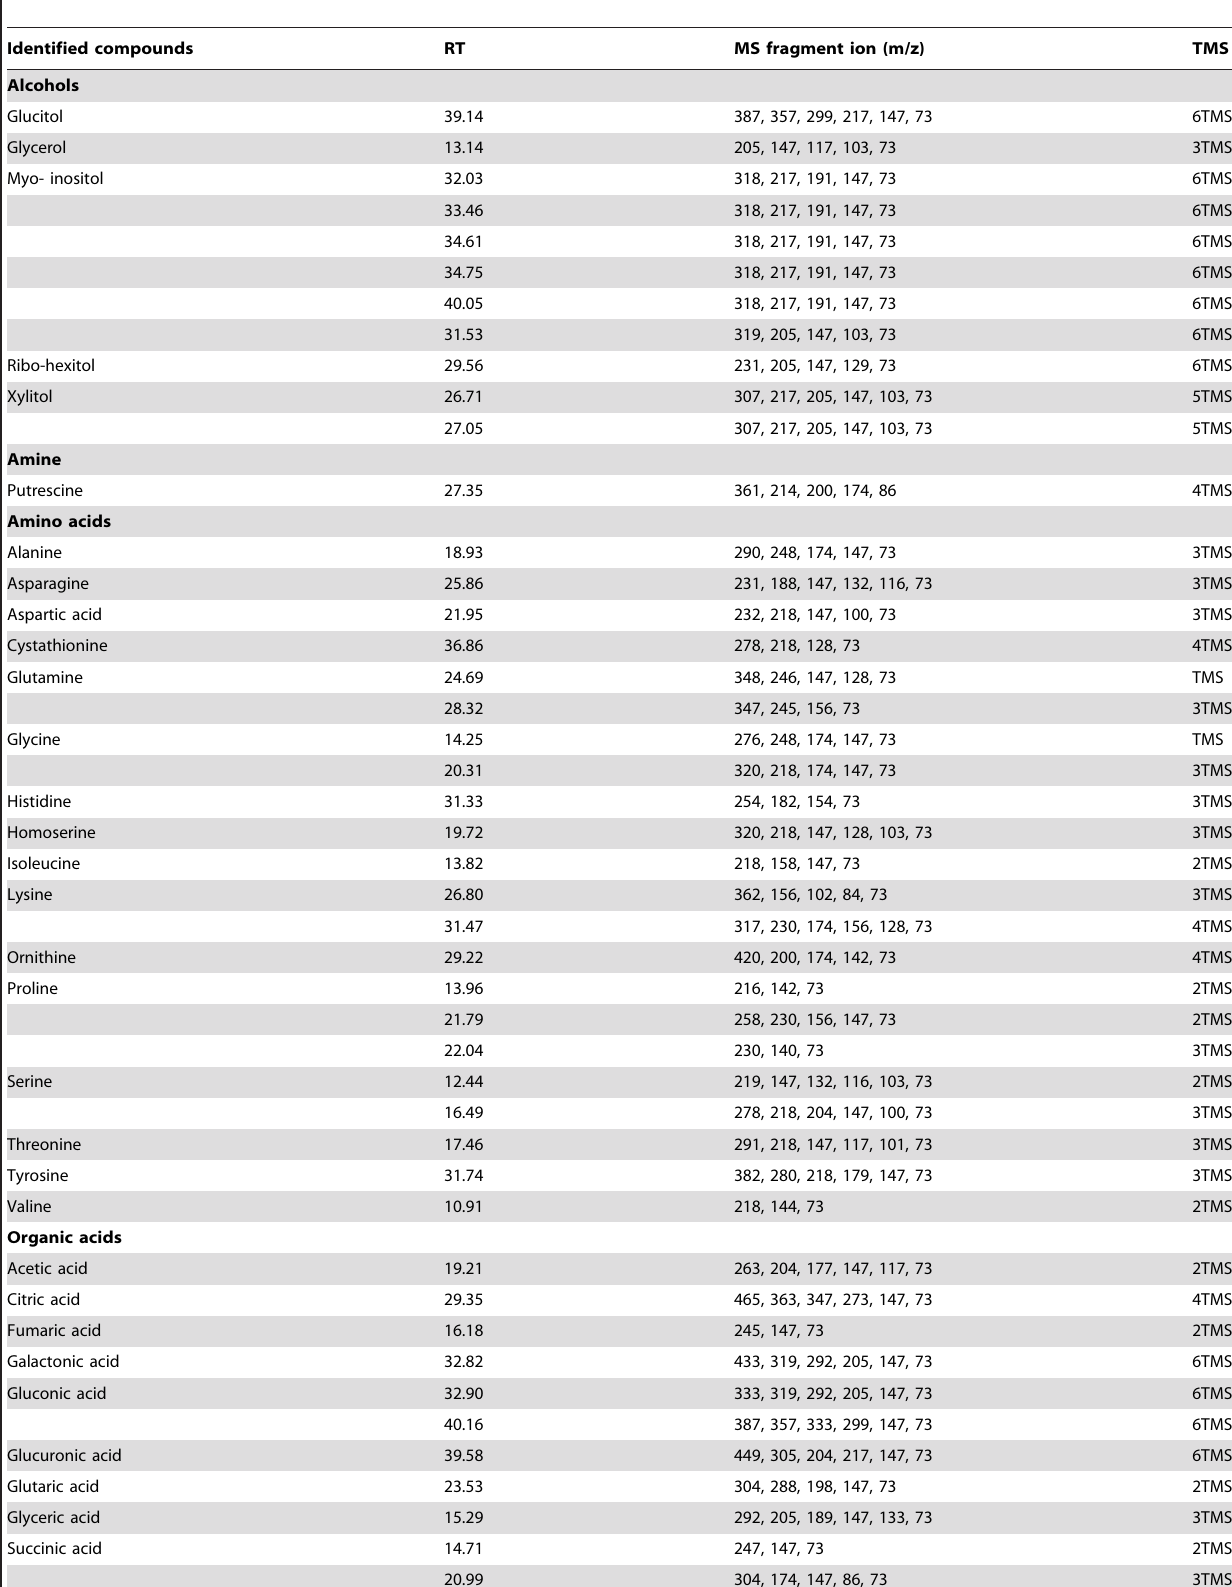
Table 3. Chromatographic data of the identified compounds from the 70% MeOH extract of C. pruinosa mycelia analyzed using